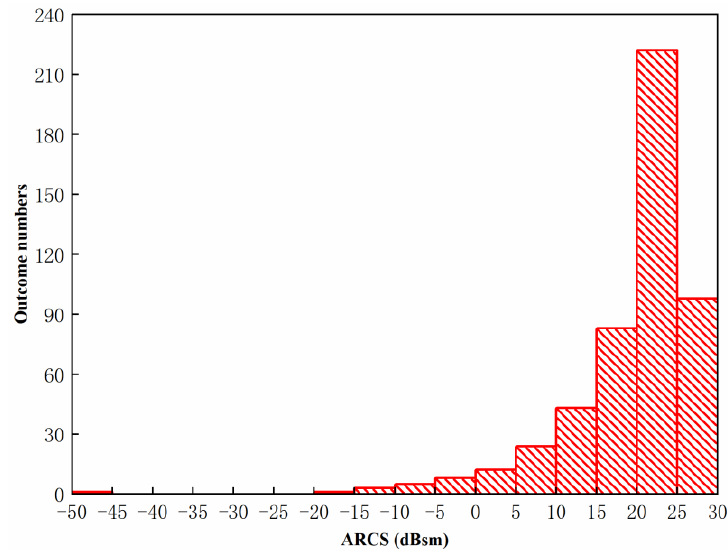
Figure 14. Statistical characteristics of ARCS obtained by the uniform distribution multi-radiators with 500 times random simulation. Table 1. The ARCS range, the outcome frequencies and the outcome rate at the uniform distribution.